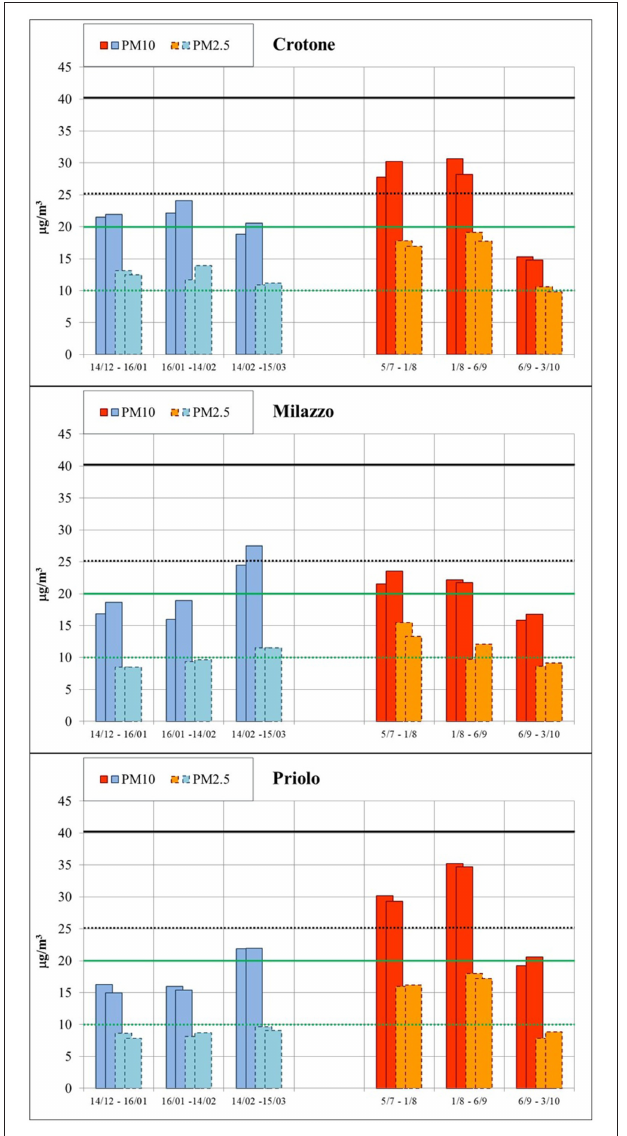
FIGURE 8 | Mass concentration of PM 10 and PM 2.5 during the winter (blue bars) and the summer (orange bars) periods at the three AERCAs. EU concentration limits are shown in black, WHO concentration limits are shown in green (PM 10 : solid lines; PM 2.5 : dashed lines).